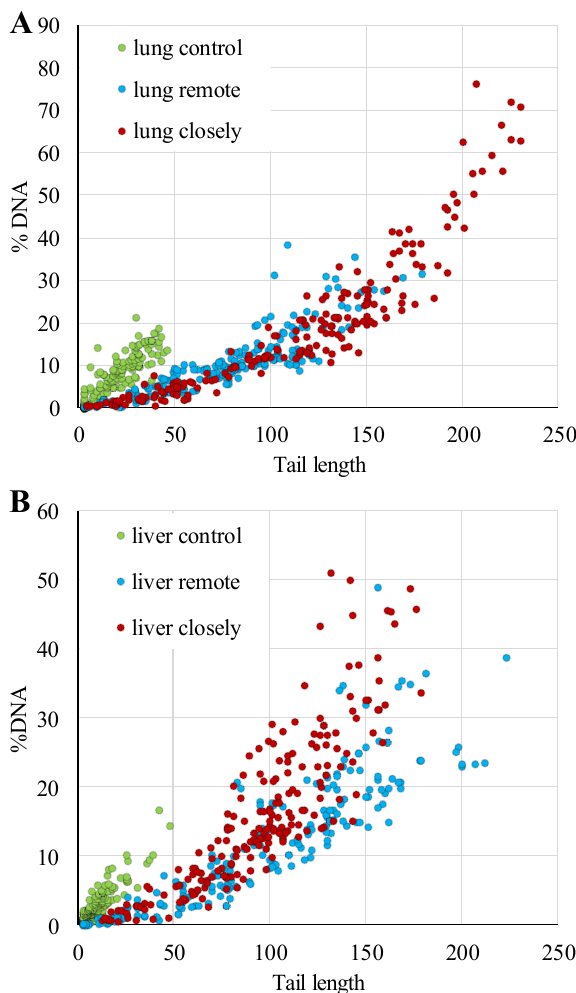
Figure 2. Correlation between the fraction of migrating DNA and tail length in comets for the lung ( A ) and liver ( B ) cells of control and Paragonimus heterotremus -infected rats. The percentage of DNA in the tail of the comet and the tail length was measured on 100 nuclei per sample in two replicates.